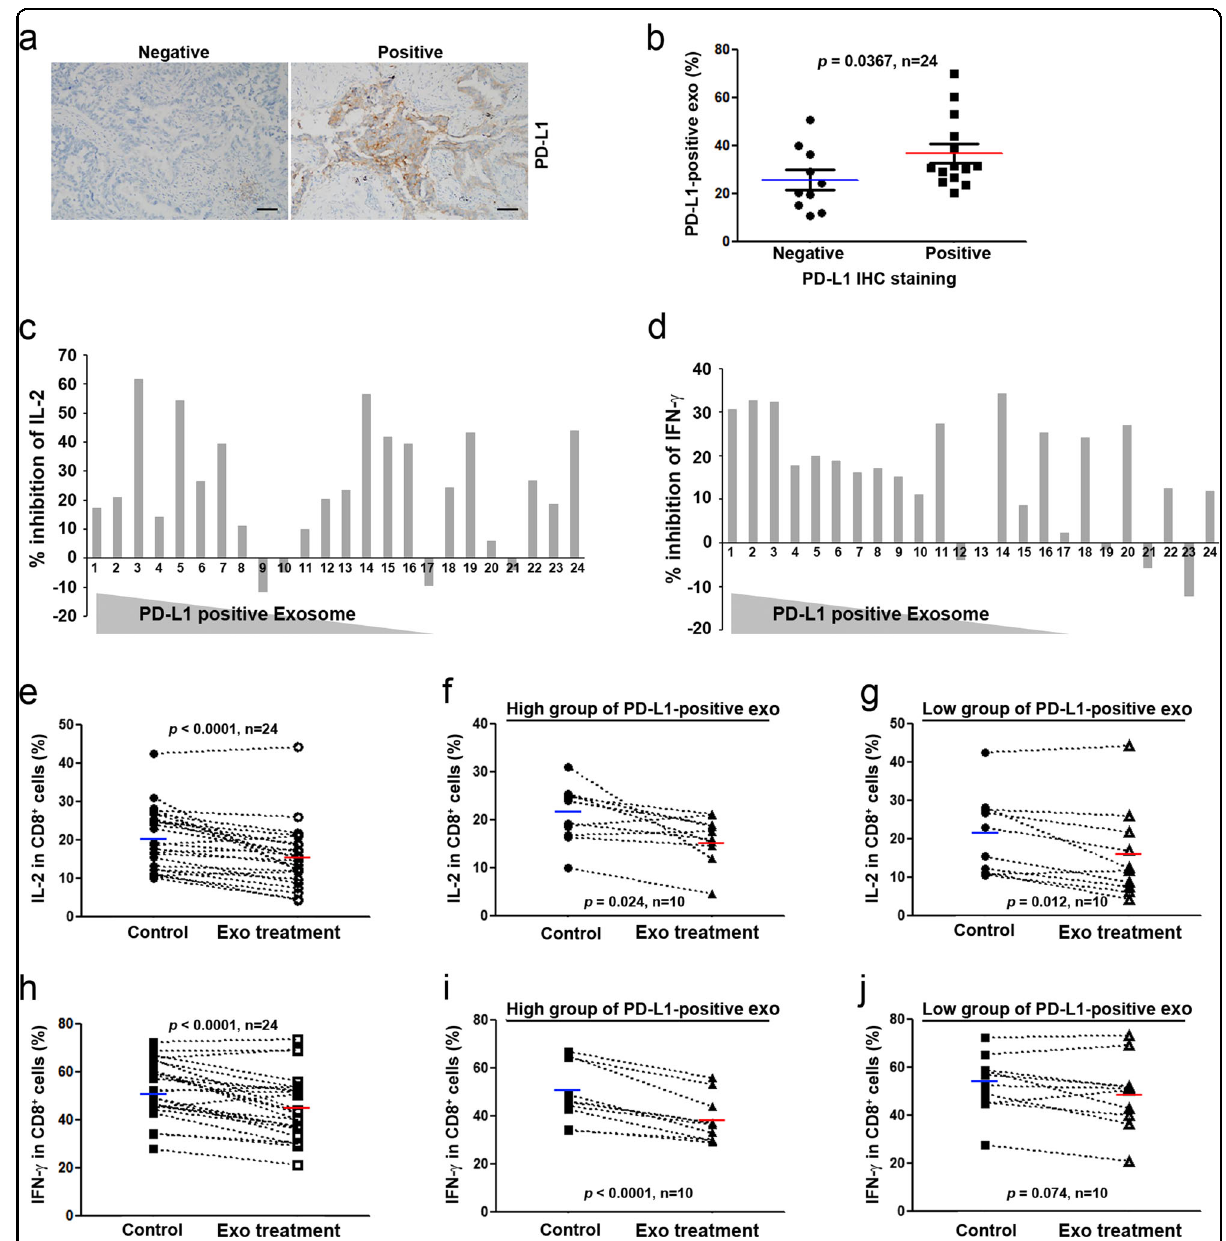
Fig. 5 Clinical implication of exosomes derived from the serum of patients with NSCLC. a Representative images of immunohistochemistry for PD-L1. Scale bars: 50 μ m. b Relationship between the number of PD-L1-positive exosomes and PD-L1 expression in tumor tissue. Each dot represents one individual; the horizontal lines represent the medians. c – j Inhibitory effect of exosomes on IL-2 and IFN- γ production in CD8 + T cells isolated from 24 patients with NSCLC. CD8 + T cells were stimulated with PMA (50 ng mL – 1 ), ionomycin (500 ng mL – 1 ), and brefeldin A (3 μ g mL – 1 ) for 4 h after treatment with autologous exosomes from the same patient. Cells were stained with anti-CD8 antibody, fi xed, and permeabilized, followed by intracellular staining with anti-human IL-2 and IFN- γ antibodies and analysis using a FACScan fl ow cytometer. c , d Inhibition of IL-2 and IFN- γ production in individual samples according to treatment with exosomes. e , h Summary of the analysis of IL-2 and IFN- γ production inhibition. Summary of the analysis of IL-2 and IFN- γ inhibition in patients with a high proportion of PD-L1-positive exosomes ( f , i ) and patients with a low proportion of PD-L1-positive exosomes ( g , j ). P = 0.0367 by an unpaired two-tailed Student ’ s t -test (B); P < 0.0001, P = 0.024, P = 0.012, and P = 0.074 by a paired two-tailed Student ’ s t -test ( e – j